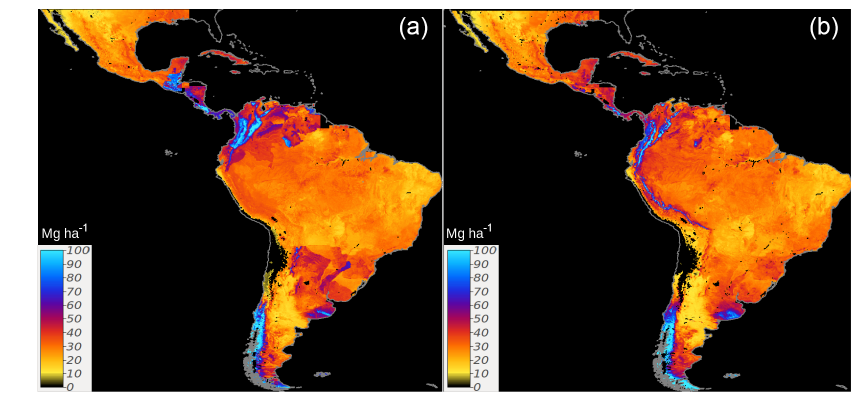
Figure 5. Country-specific (a) and regional (Latin America) (b) predictions of SOC based on a linear ensemble of methods. We present the units as Mgha for visualization purposes. These units were used to reduce the digits of the value range and highlight larger differences between SOC maps.